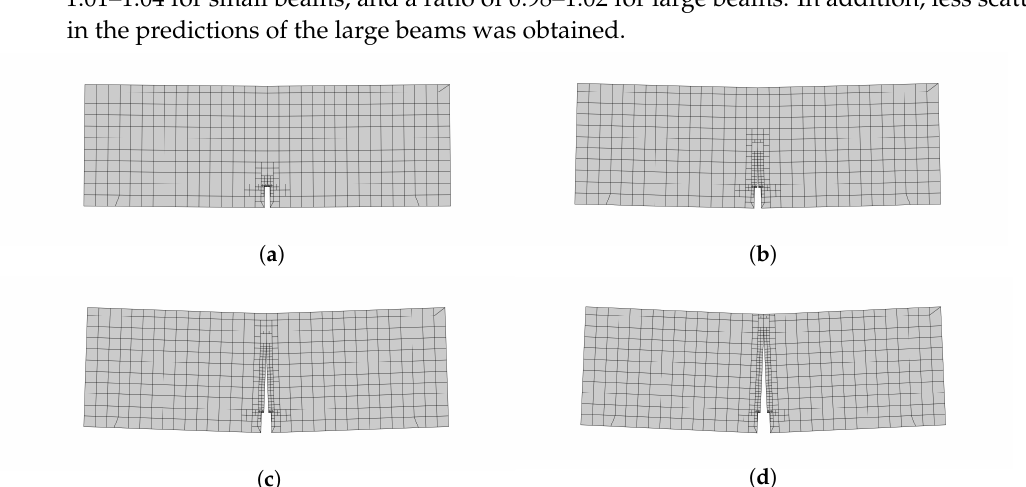
Figure 7. Crack propagation in SBEM subjected to three-point bending tests. ( a ) Load = 8.347 kN (pre-peak), ( b ) load = 18.75 kN (peak load), ( c ) load = 5.763 kN (post-peak), ( d ) load = 2.514 kN (post-peak).